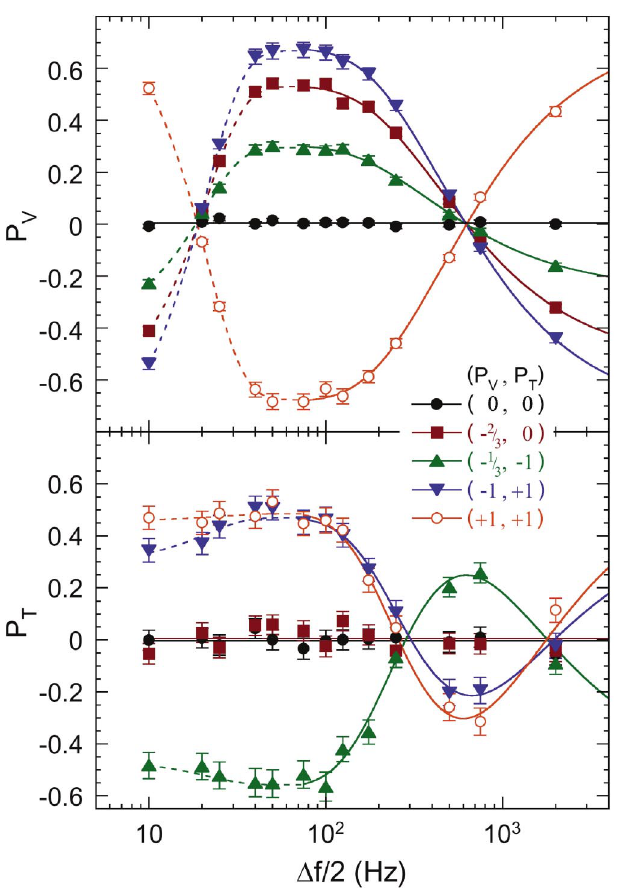
6. (Color) The measured vector and tensor deuteron polar- izations at 1850 MeV =c are plotted against the rf dipole’s frequency half-range (cid:18) f= 2 . The rf dipole’s ramp time (cid:18) t was dl was 0 : 54 T mm . The top and bottom solid 50 s, and its R B rms curves are fits to the data at and above (cid:18) f= 2 (cid:2) 75 Hz using Eqs. (9) and (11), respectively. The dashed lines are to guide the